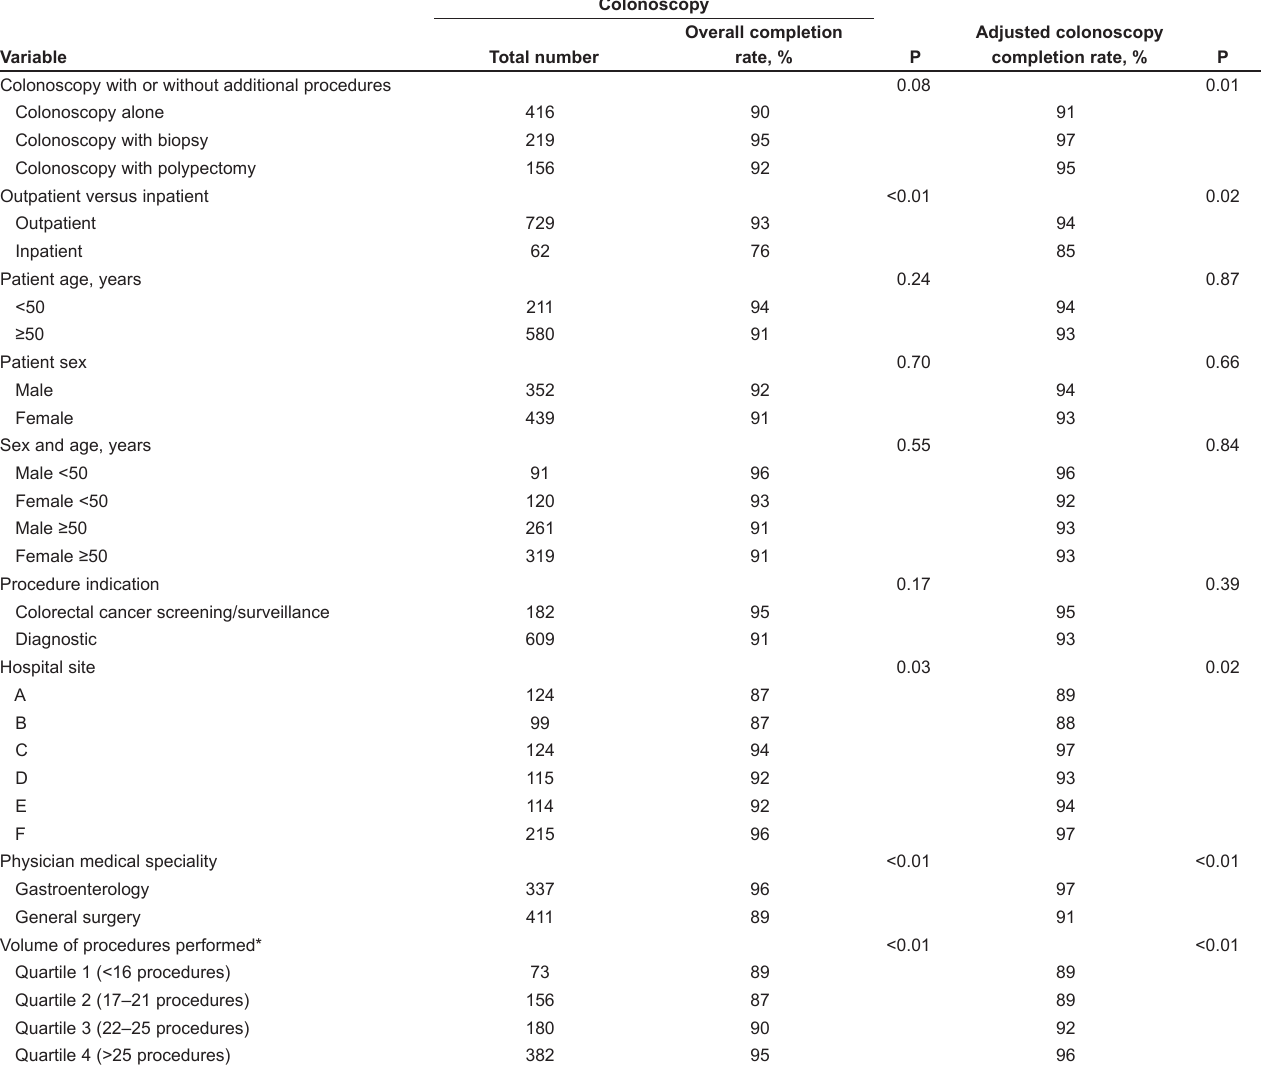
TABle 2 Overall and adjusted colonoscopy completion rates, stratified according to type of procedure, indication of procedure, patient characteristics and site of the procedure for colonoscopies performed in Winnipeg (Manitoba) hospitals